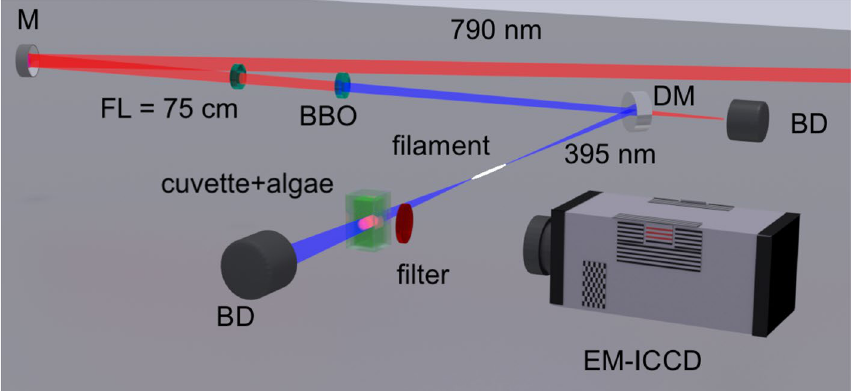
Figure 8. Experimental schematic for the filament-induced fluorescence imaging of algae samples. BD beam dump, DM dichroic mirror, FL focal length, M